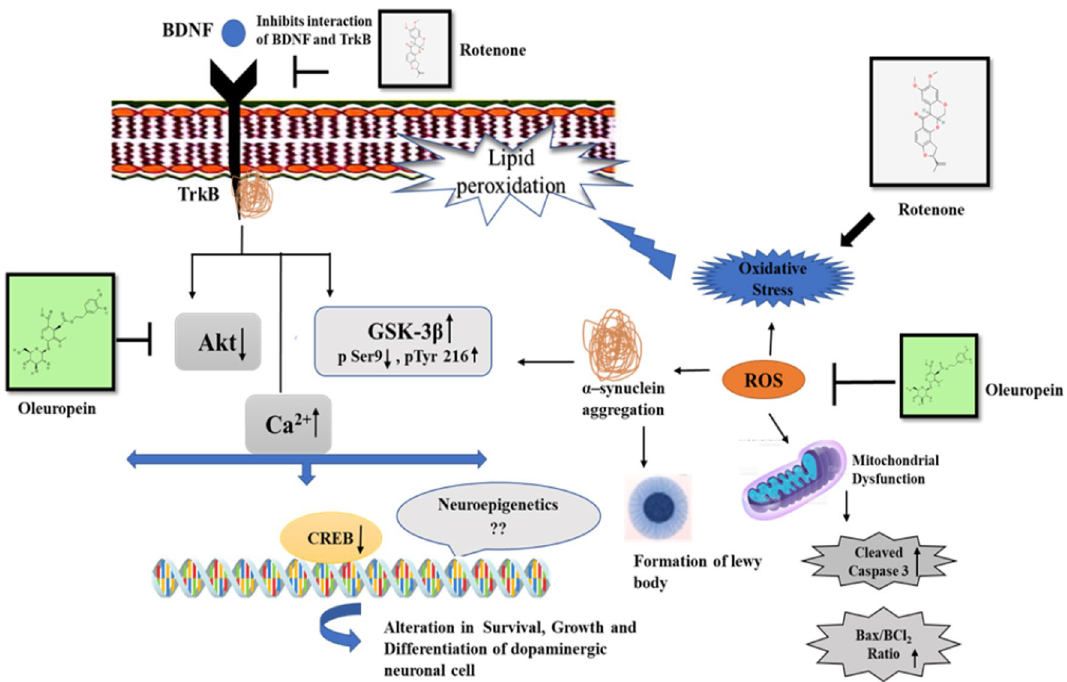
Figure 10. The mechanism of neuroprotection of Oleuropein in rotenone induced PD mouse